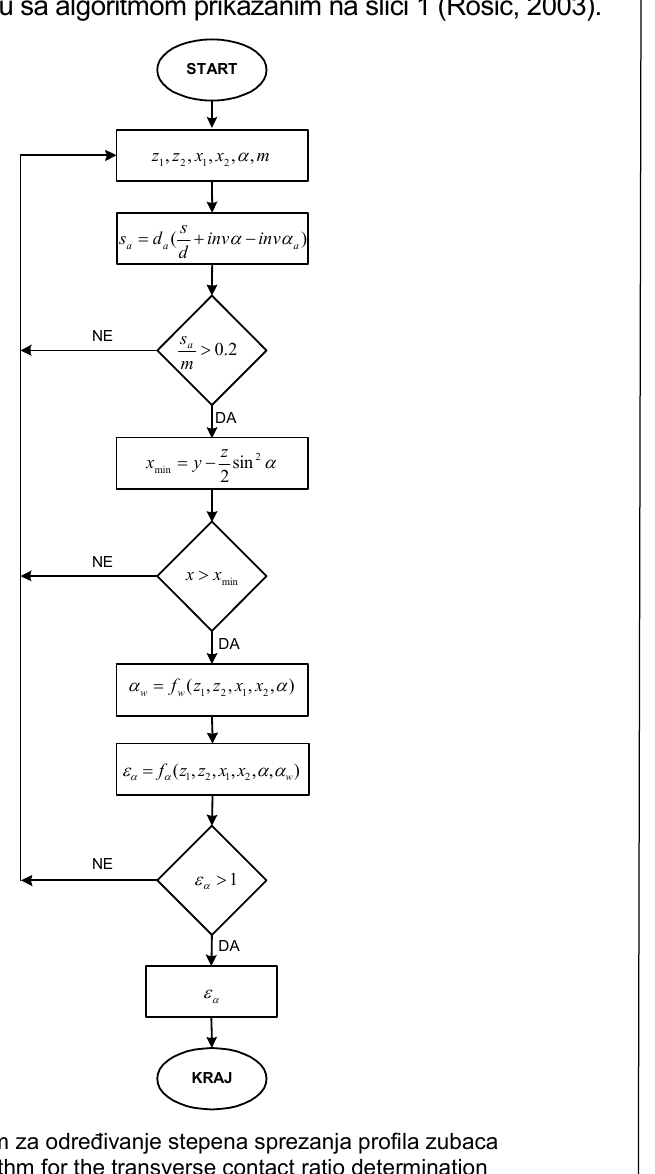
Figure 1 – Algorithm for the transverse contact ratio